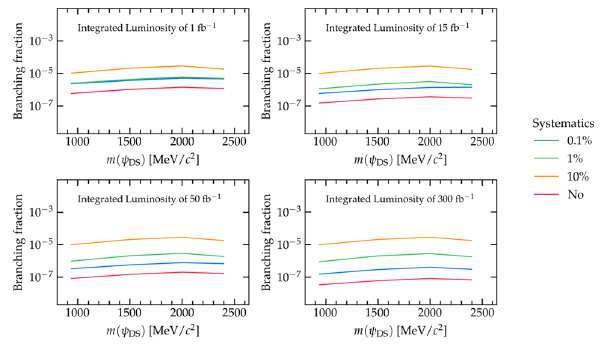
Fig. 7 Same as Fig. 6, but now for the B + → ψ DS Λ c ( 2595 ) +